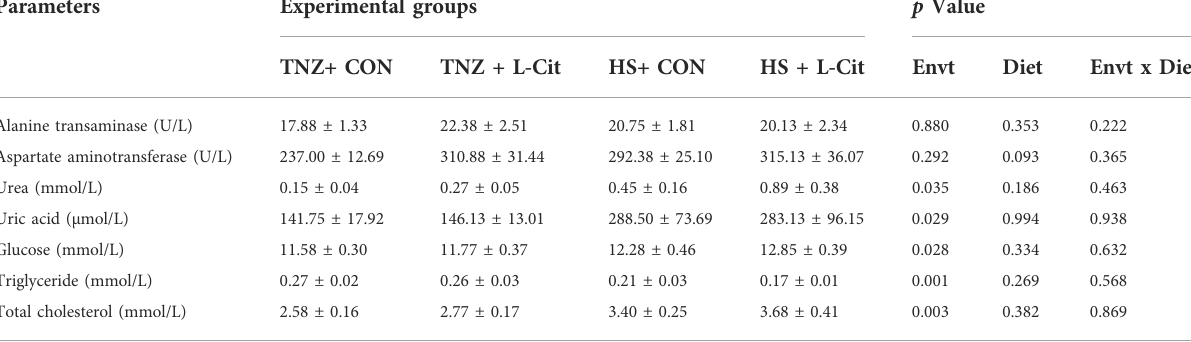
TABLE 5 Effects of L -citrulline supplementation on the plasma metabolites of broilers during heat stress.